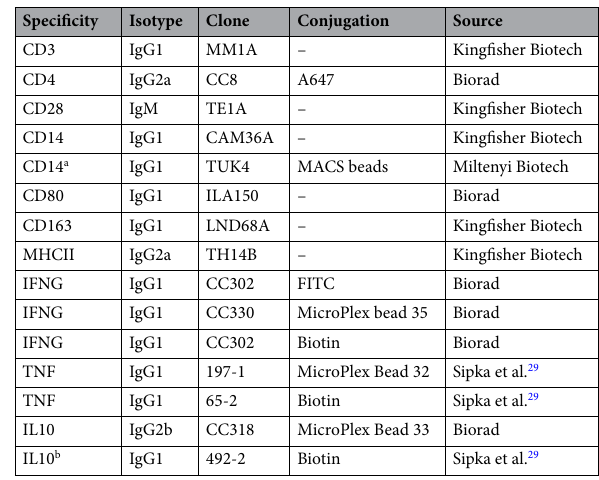
Table 1. Monoclonal antibodies used for flow cytometry, cell culture, and cytokine detection. a Anti-human cross reactive with bovine b Anti-equine cross reactive with bovine. All other antibodies are